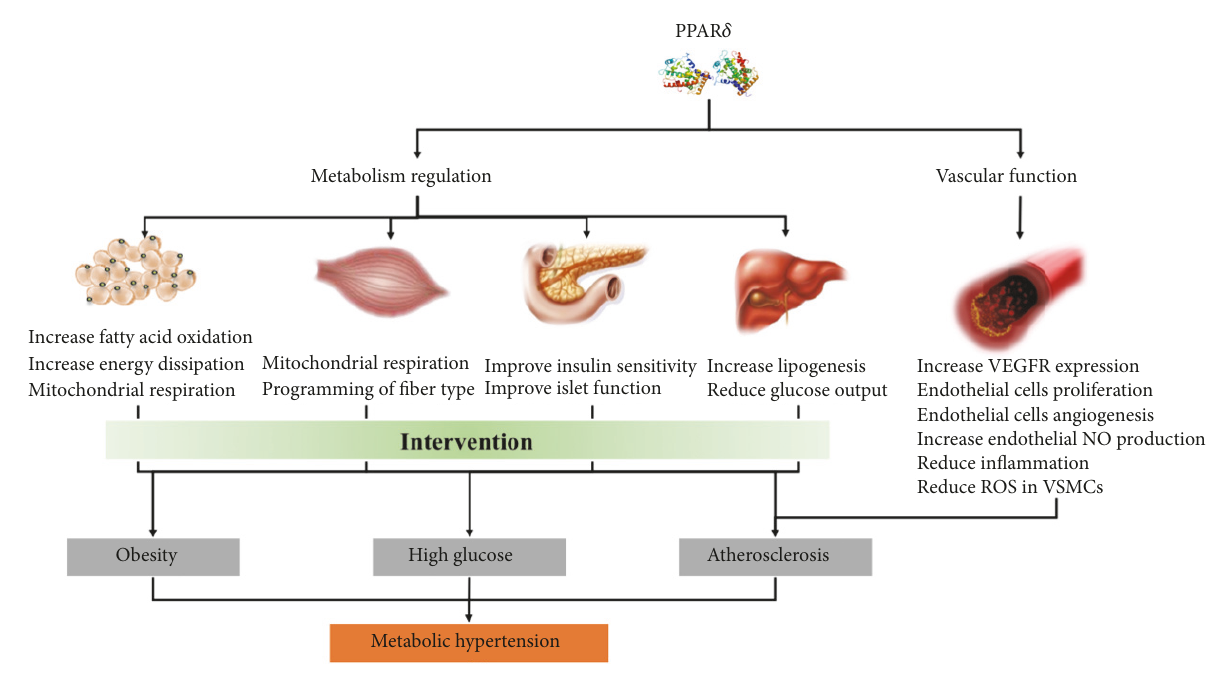
Figure 1: Potential role of PPAR 𝛿 in the metabolism regulation and vascular